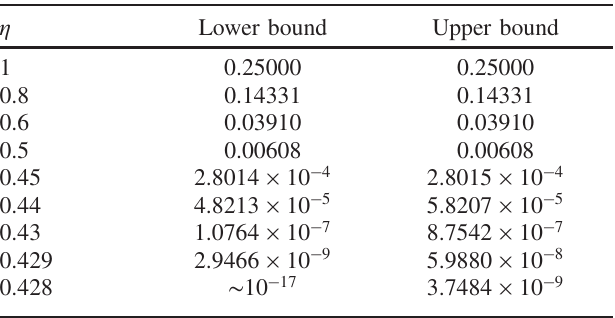
TABLE I. Lower and upper bounds on the violation of the I η Þ inequality in the two-qubit Hilbert space. The local 3322 ð bound is equal to 0 for any η